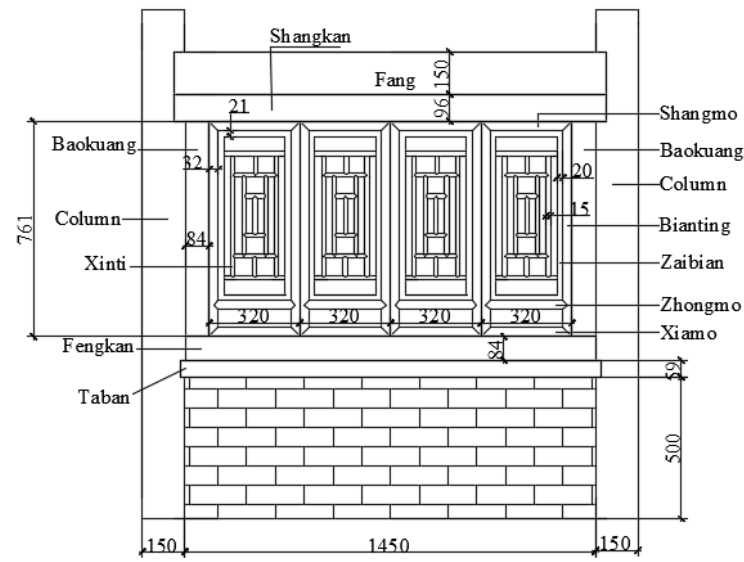
Figure 2. Dimensions of the experimental model (mm).